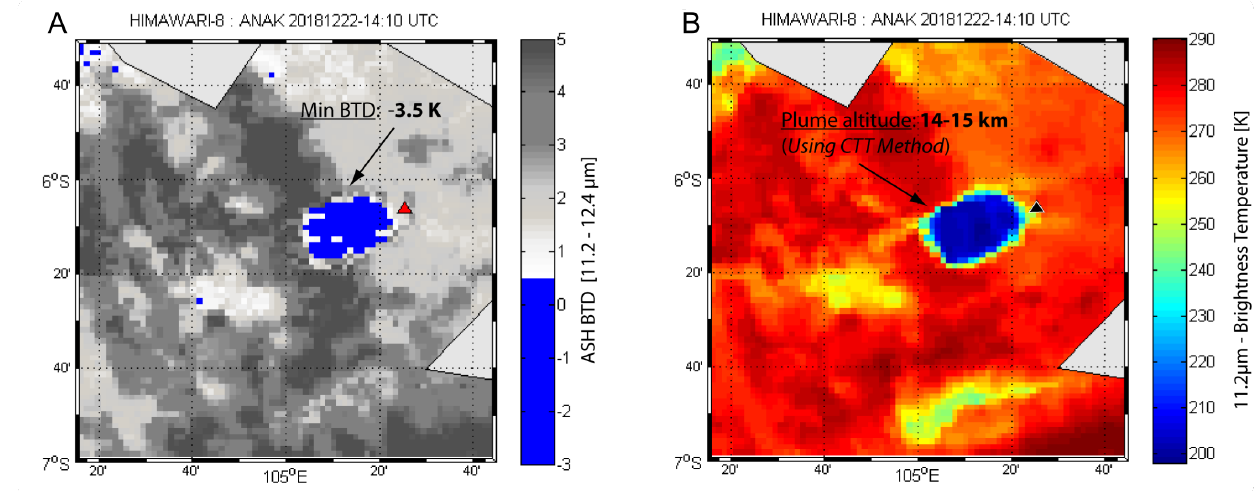
Figure 2: Ash plume characterization. [A] Brightness Temperature Di ff erence (BTD) of band L02 (11 . 2 µm) and L03 (12 . 4 µm) from Himawari-8 satellite, showing the ash plume at 14:30 UTC on 22/12/2018. [B] Brightness Temperature (in Kelvin) at 11 . 2 µm used for the plume height determination (see text for